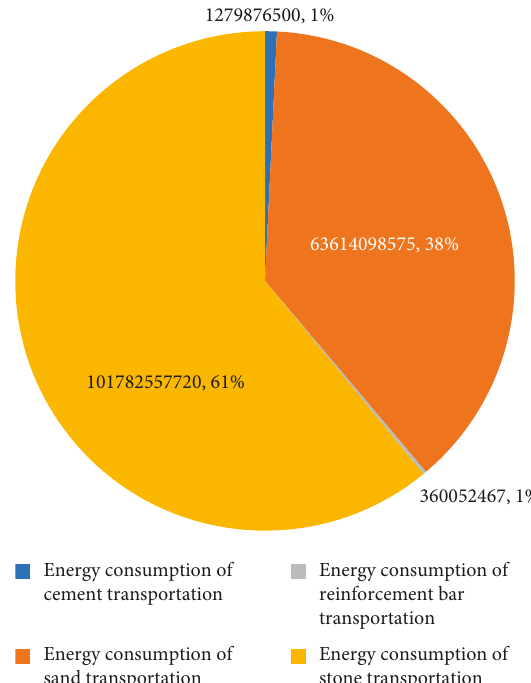
Figure 12: Energy consumption of raw material transportation of prefabricated columns.